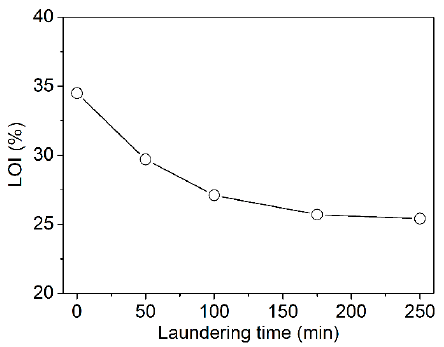
Figure 16. LOI of the treated wool fabric after laundering.